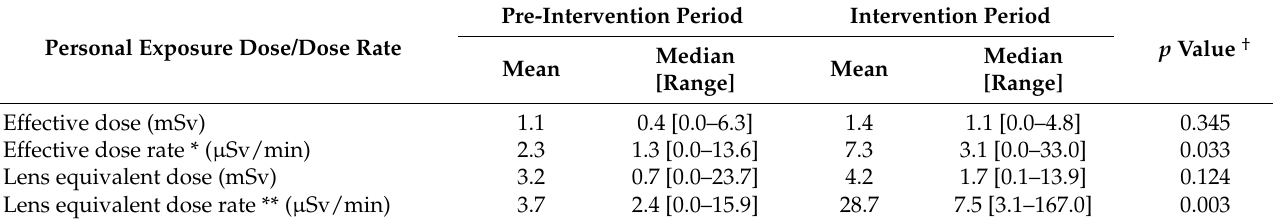
Table 5. Personal exposure dose and dose rate for physicians ( n =